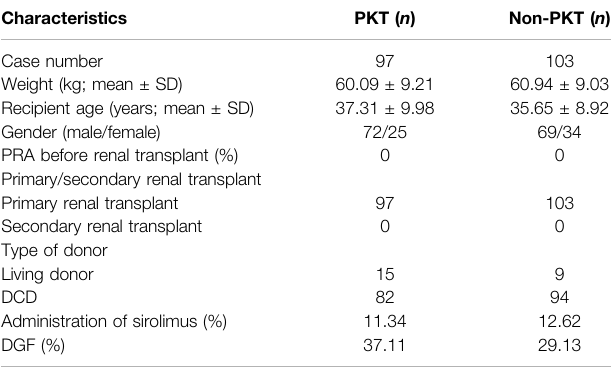
TABLE 1 | Basic demographics of kidney transplantation patients in this